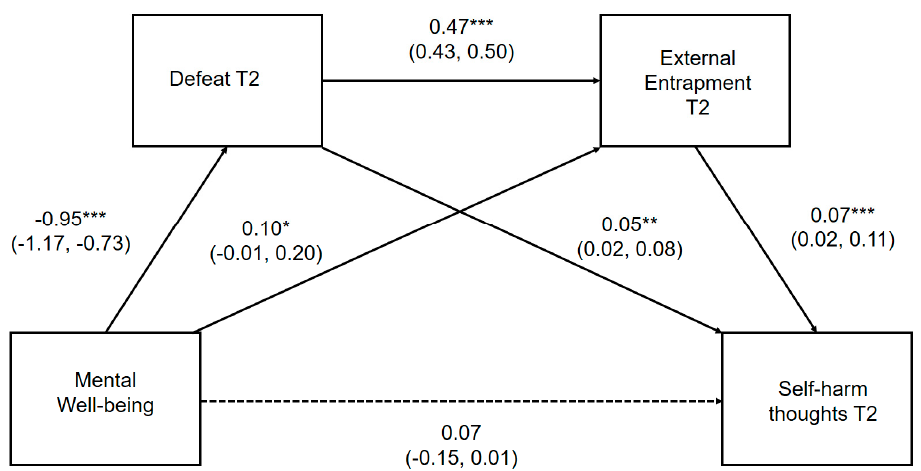
Figure 5. Serial multiple mediation model for the association between mental well ‐ being and prospective self ‐ harm thoughts, via defeat and external entrapment, * p < 0.05; *** p < 0.001 Serial multiple mediation model with unstandardized regression coefficients and 95% bias corrected confidence intervals. Significant pathways are highlighted in bold.